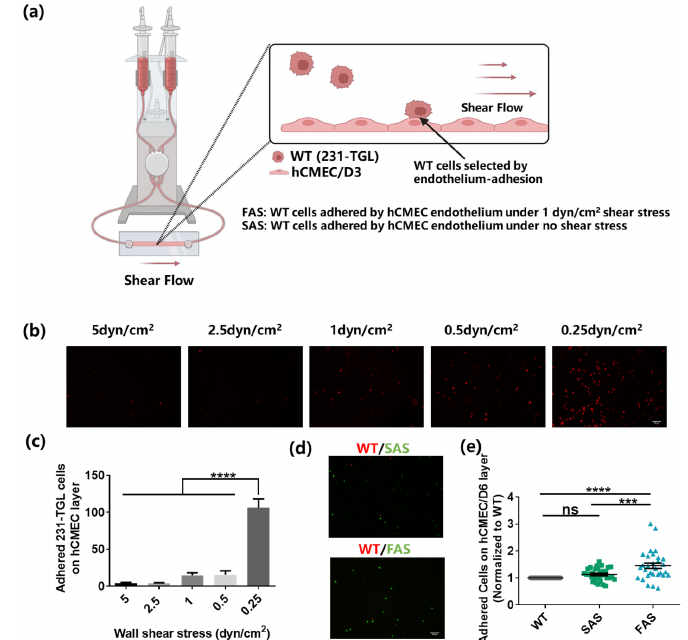
Figure 1. Brain-endothelium-adhesion-based selection of breast cancer cells. ( a ) The illustration of in vitro system for brain-endothelium-adhesion-based selection of breast cancer cells (created with biorender.com). ( b , c ) The adhesion of tumor cells to the brain endothelium under various levels of fl uid shear stress. WT cells were labeled with red cell tracker and perfused into the fl ow chamber slides to adhere to the brain endothelium under 0.25, 0.5, 1, 2.5, and 5 dyn/cm 2 shear stress for 15 min. The number of adhered cells was counted under a fl uorescence microscope. Scale bar = 100